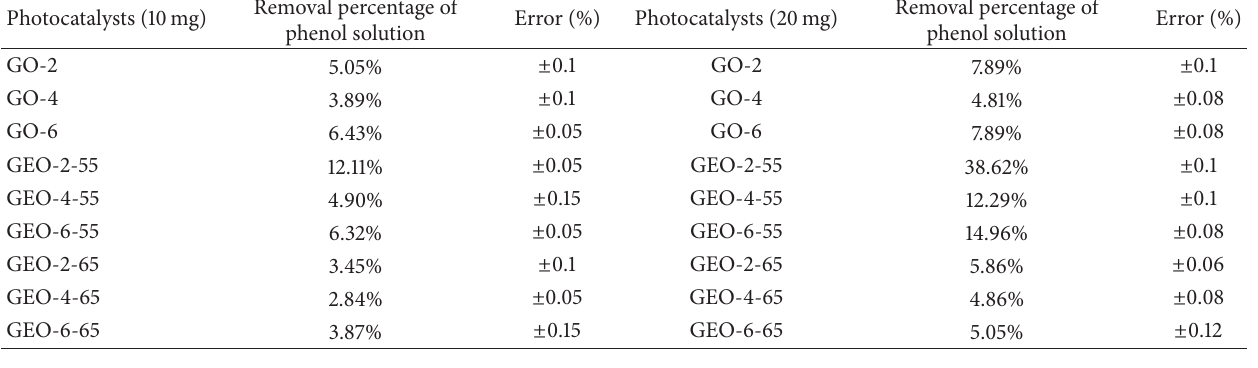
Table 4: Removal percentage of phenol in water in the photocatalytic test using GO and GEO.